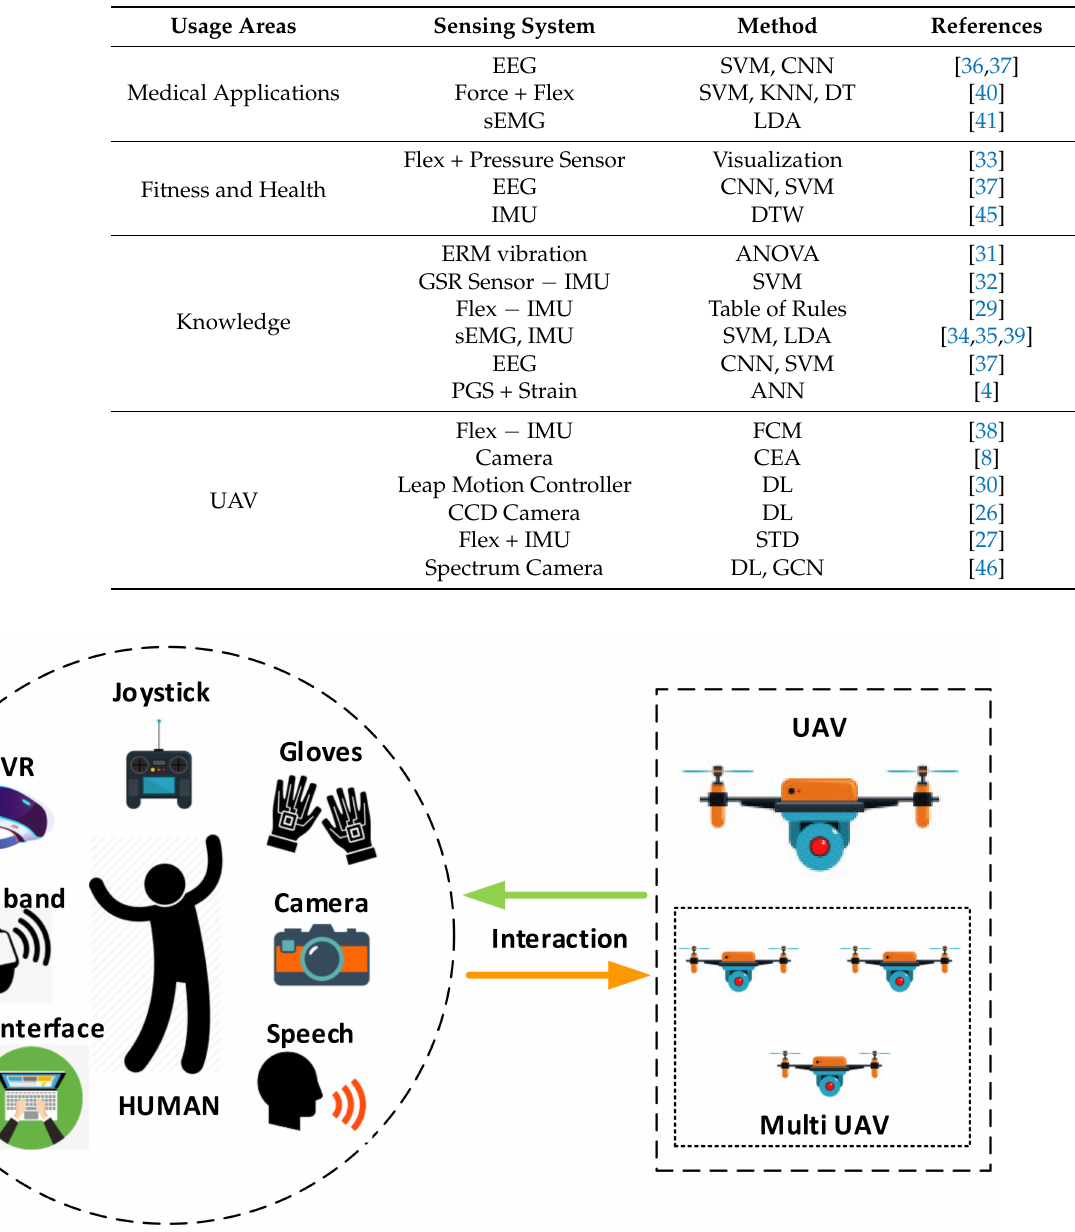
Table 1. Usage areas, sensing system, and applied study methods in the literature.